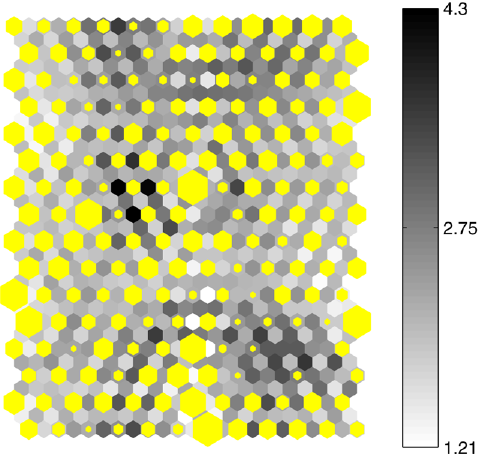
Figure 4. The toroid SOM map with 192 (16 × 12) nodes obtained for the Vesuvius dataset: each yellow hexagon indicates a cluster of data and its size represents the number of signals which fall in it. The gray hexagons specify the Euclidean distances between the pro- totypes and so between the feature vectors according to the gray level scale shown on the right. The toroidal shape, in which the lower and upper edges and the left and right sides are joined, is dis- played as sheet to facilitate the cluster visualization.